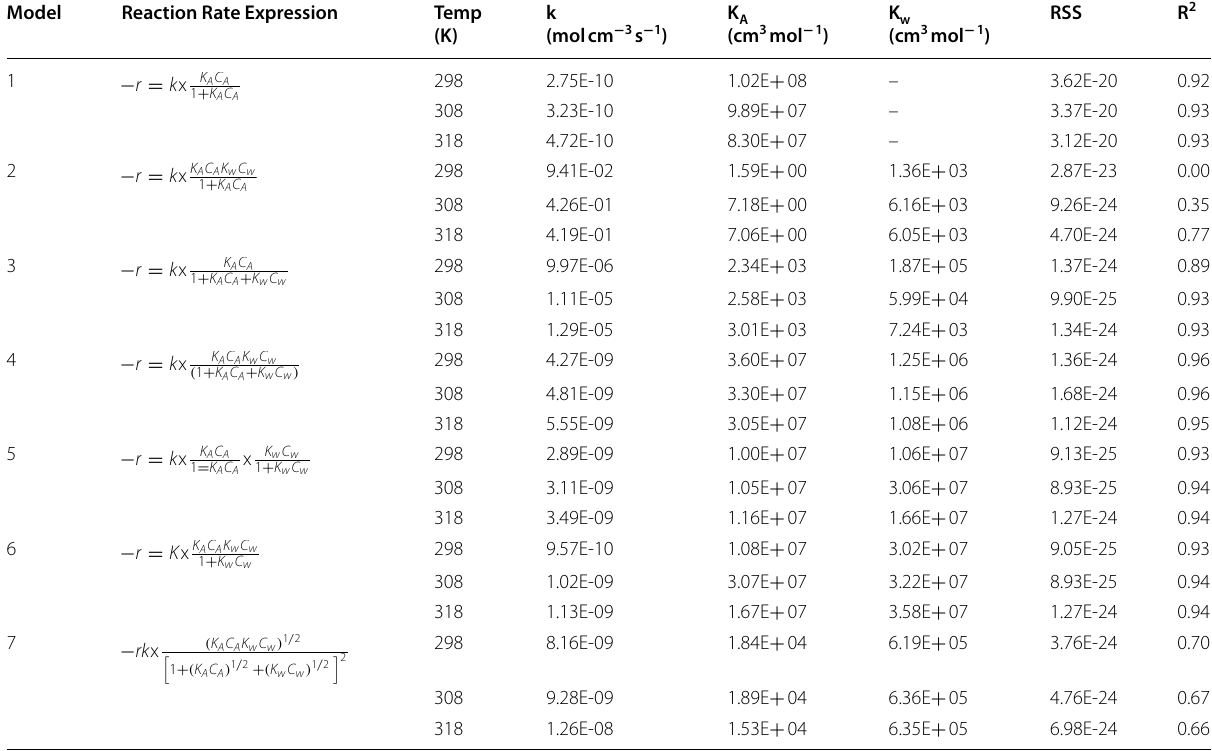
Table 4 The calculation results for Langmuir‑Hinshelwood models 1–7